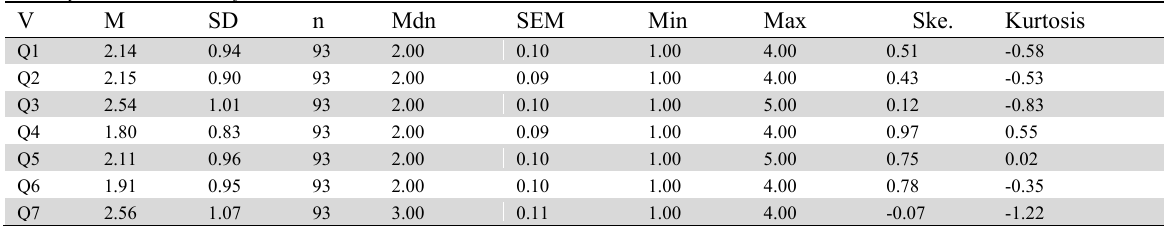
Summary Statistics Table for Interval and Ratio